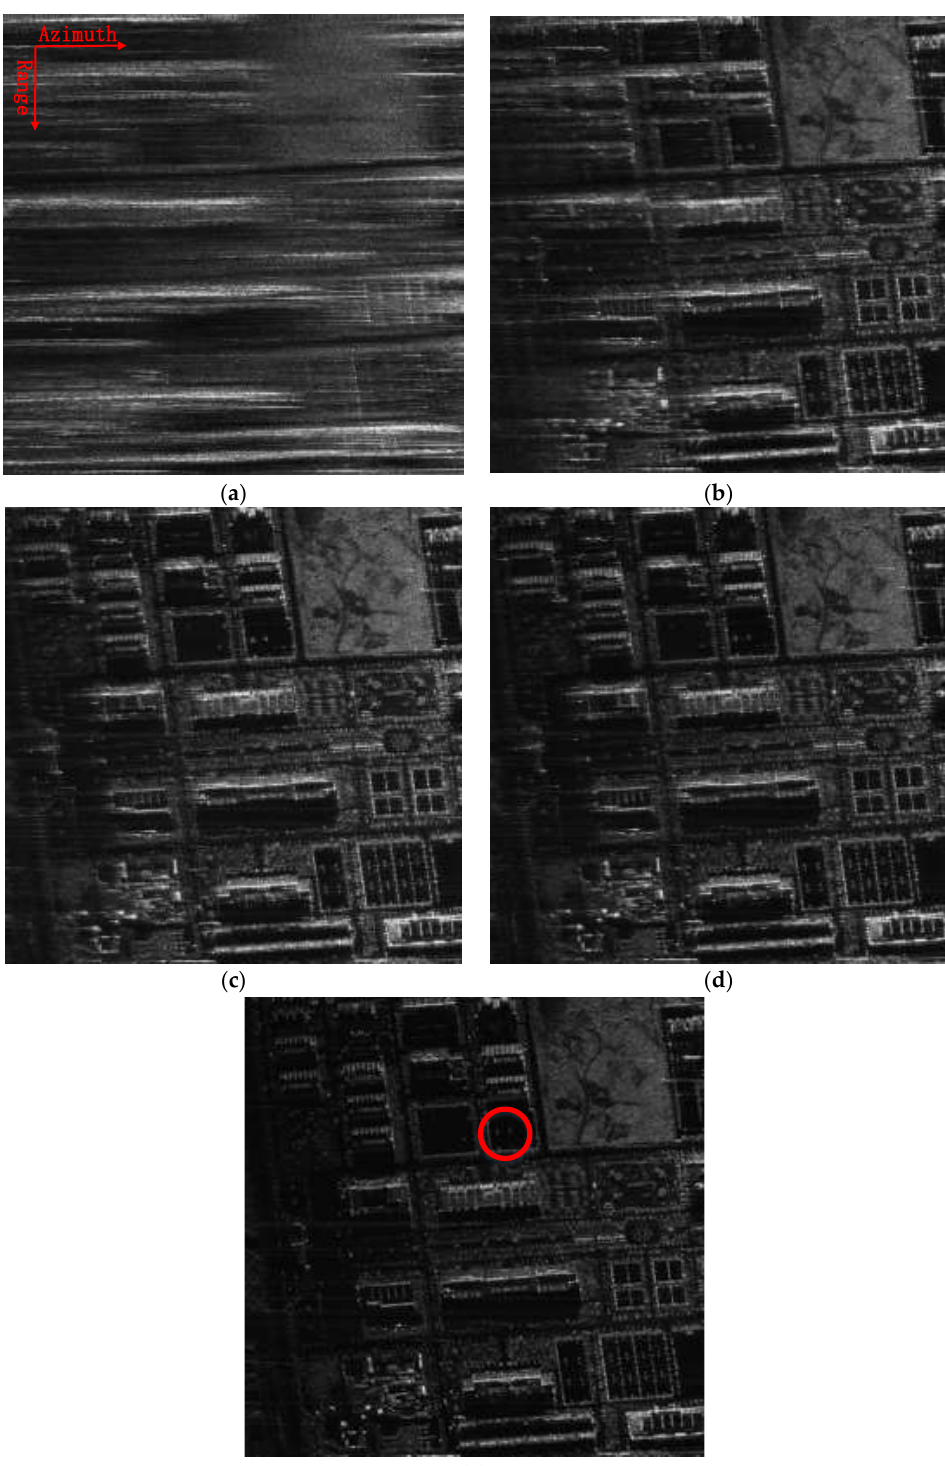
Figure 5. A typical area in Figure 3 are zoomed and compared with the other methods. ( a ) Focused without Motion Compensation (MOCO); ( b ) Focused with only range-varying Phase Gradient Autofocus (PGA); ( c ) Focused combining stripmap RDM and range-varying PGA; ( d ) Focused combining sliding spotlight RDM without WTLS and range-varying PGA; ( e ) Focused combining sliding spotlight RDM with WTLS and range-varying PGA.